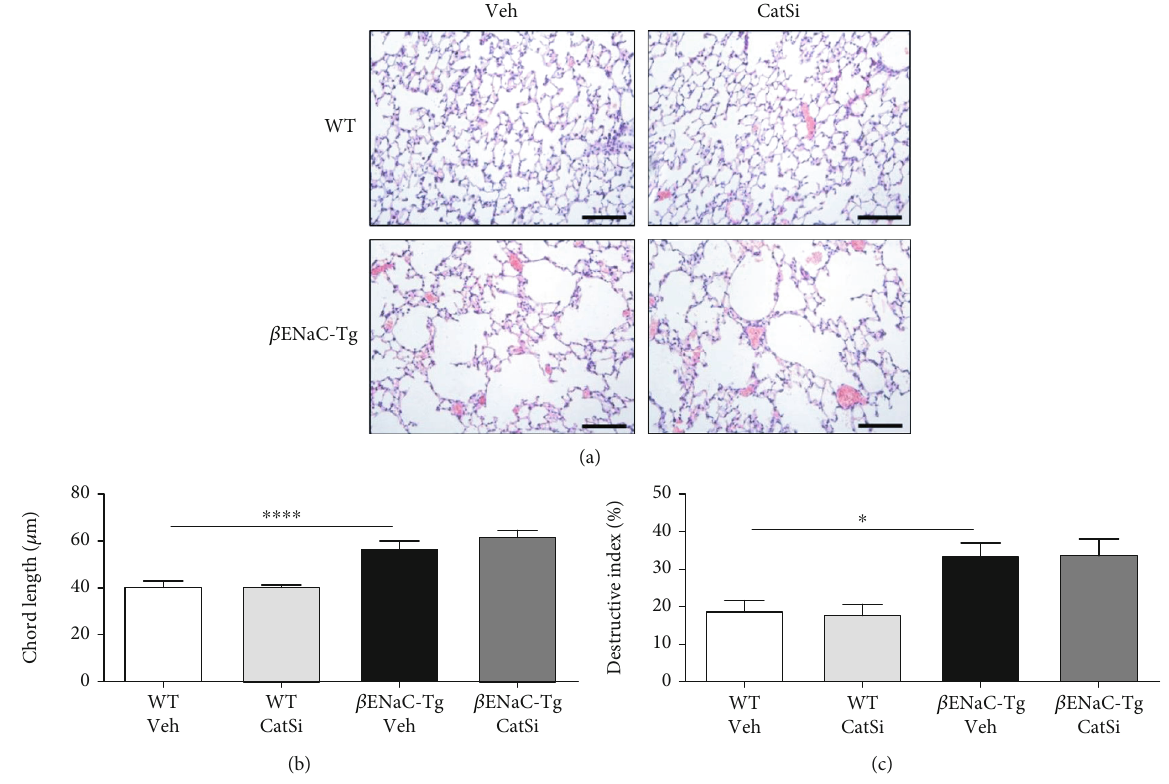
Figure 7: Cathepsin S inhibition does not reduce emphysema-like lung damage. Four-week-old WT and β ENaC-Tg mice were treated daily with cathepsin S inhibitor VBY-999 (CatSi, 100mg/kg) or dextrose vehicle control (veh) for 14 days. (a) Representative images of lung sections stained with haematoxylin and eosin (H&E) used to assess airway damage. Scale bar = 100 μ m . (b) Mean linear intercept and (c) destructive index measurements were assessed from the H&E-stained lung sections as detailed in materials and methods ( n = 7 ‐ 8 per group). ∗ P < 0 : 05 , ∗∗∗∗ P < 0 : 0001 , (b) one-way ANOVA with Tukey ’ s multiple comparisons test, (c) Kruskal-Wallis test with Dunn ’ s multiple comparisons